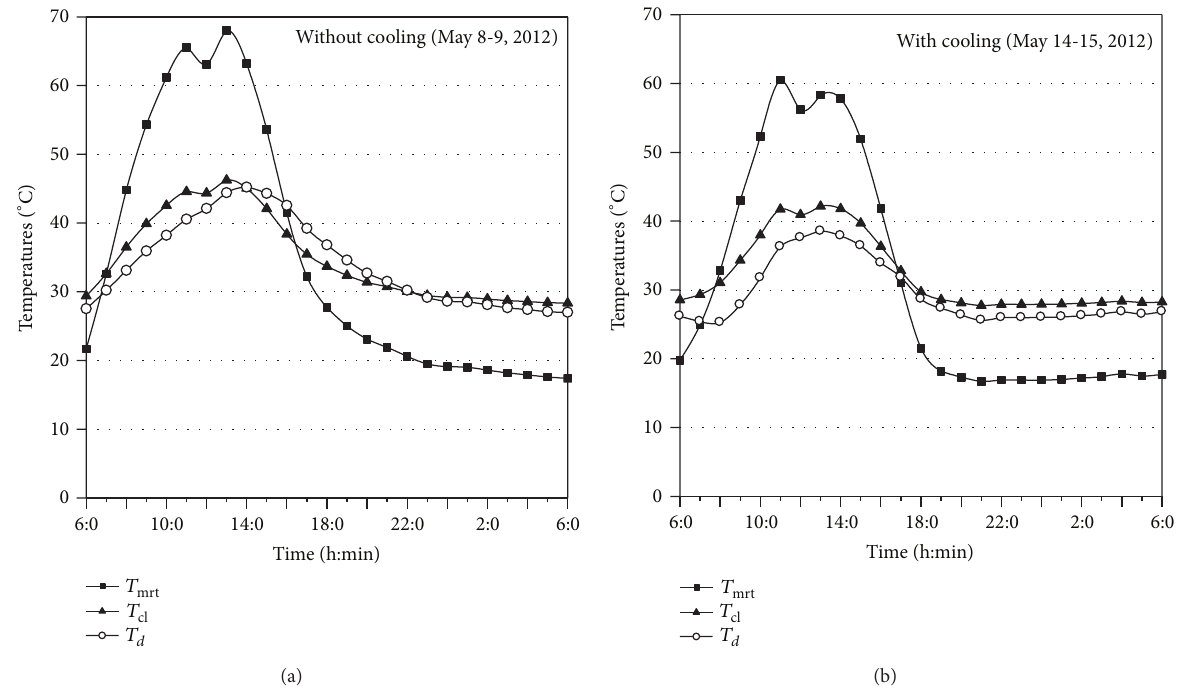
Figure 3: Time course of the mean riant temperature ( 𝑇 greenhouse: (a) without cooling and (b) with cooling of the inside air.